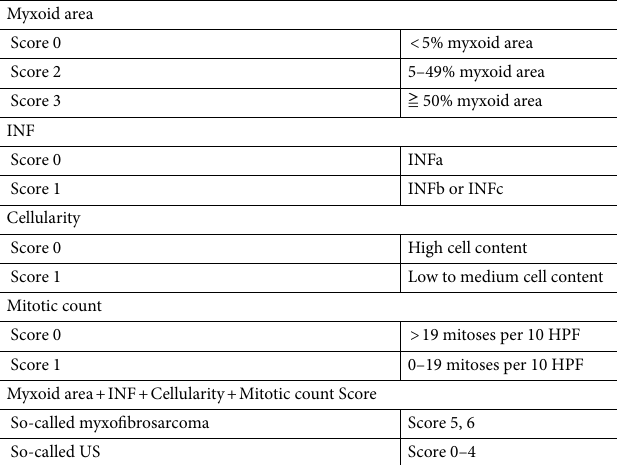
Score Table 4. Histological scoring. High cell content: ≧ 50%. Low to medium cell content: < 50%. HPF high-power field; 1 HPF = 0.2374 mm 2 .